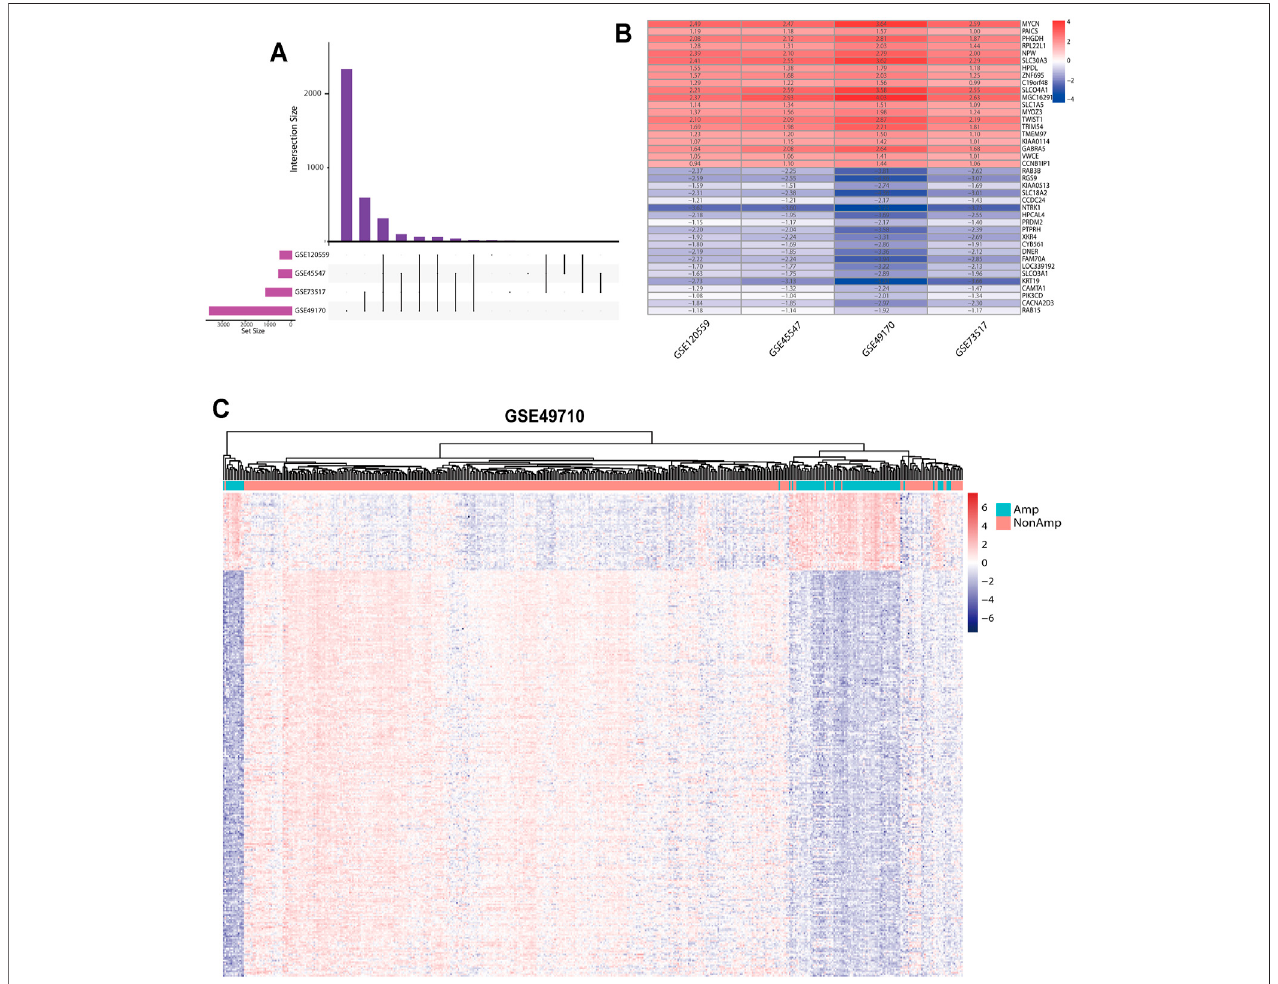
FIGURE2| DEGsbetweentheMYCNampli fi cationandnonampli fi cationgroups. (A) VenndiagramoftheDEGsobtainedfromfourGEOdatasets. (B) Heatmapof the top 20 upregulated and downregulated DEGs derived from the GEO data sets. Red represents upregulated DEGs, and blue represents downregulated DEGs. (C) Heatmap of the 319 DEGs after integrated analysis in the GSE49710 data